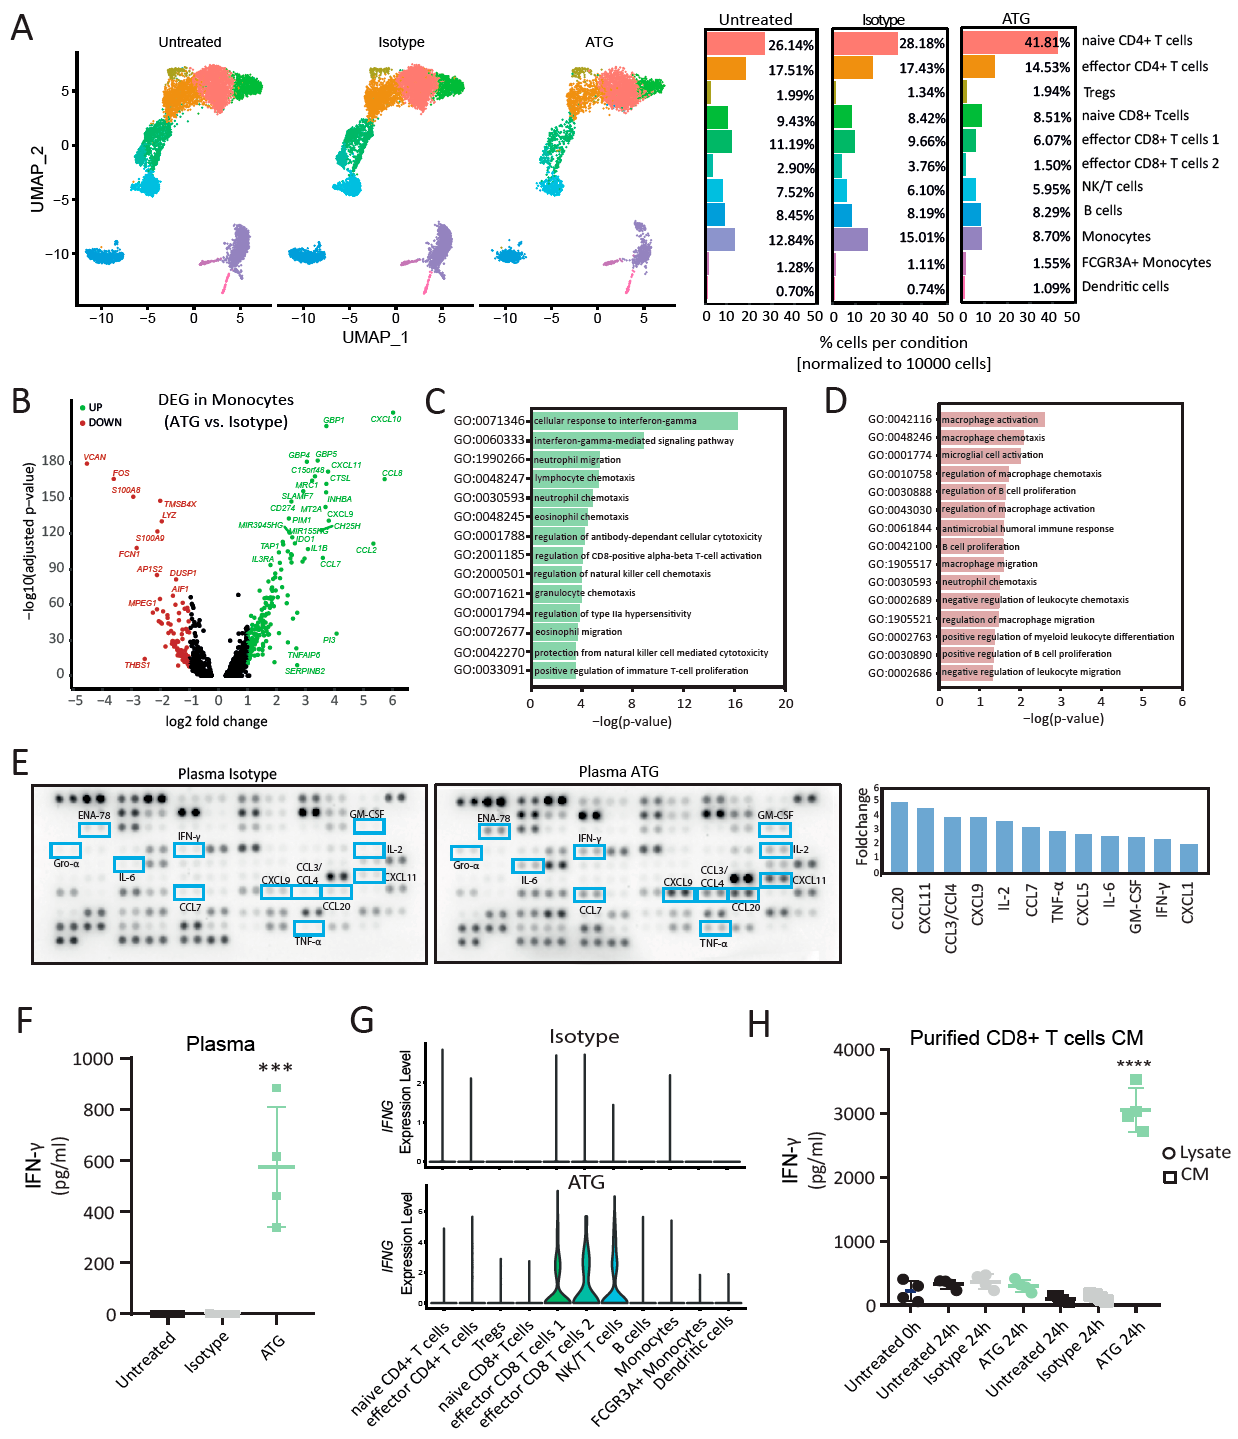
Figure 1. Single-cell RNA sequencing of ATG-treated white blood cells reveals transcriptional al- terations in monocytes in response to IFN- γ . ( A ) Uniform manifold approximation and projection (UMAP) plot of untreated (Untreated), isotype-treated (Isotype) and ATG-treated (ATG) immune cells from whole blood reveals 11 distinct cell types present in all conditions. Relative distribution of each cell type across all investigated conditions is shown in the bar plots. N = 2 donors per con- dition. ( B ) Volcano plot showing differentially up- (green, log 2 FC > 1 and adj. p -value < 0.05) and downregulated (red, log 2 FC < − 1 and adj. p -value < 0.05) genes (DEG) in monocytes (ATG vs. Isotype) with annotations. Adj. p -values were obtained after Benjamini–Hochberg correction. Bar plot